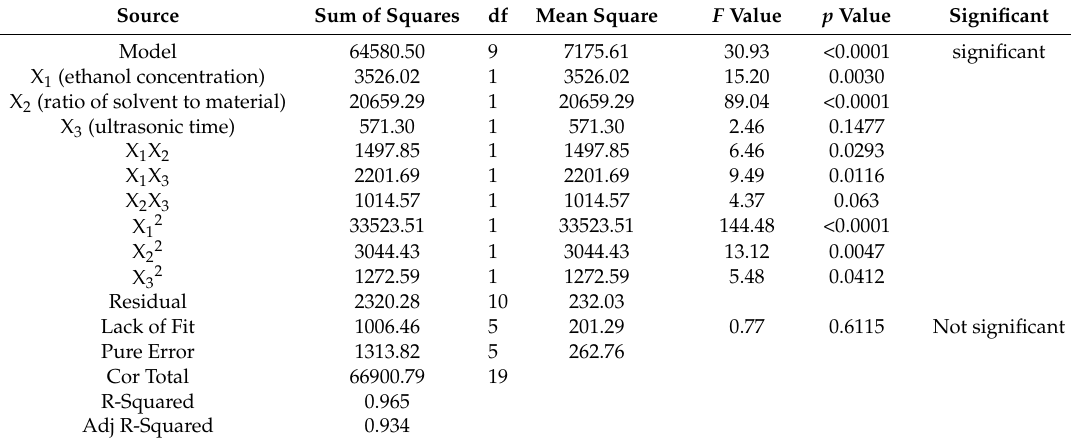
Table 2. ANOVA for the response surface quadratic